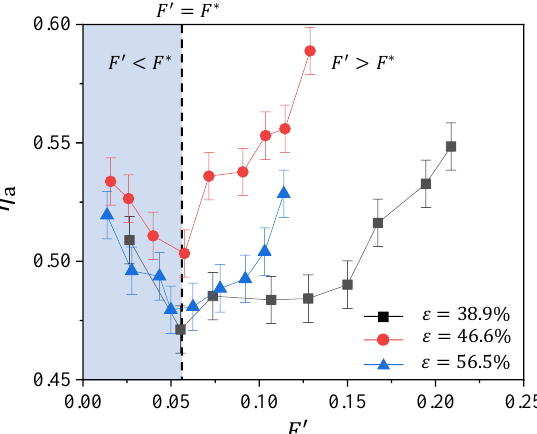
Figure 9. Variation of average cooling efficiency η a with the modified blowing ratio F (cid:48) for different porosity ε